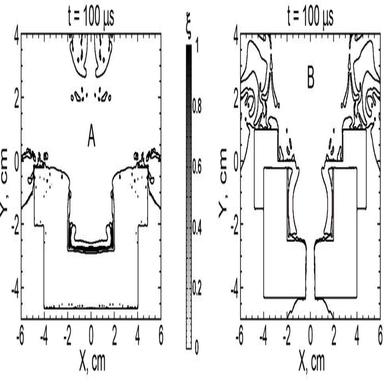
Results of the consolidation modelling (parameter ξ) for the diatomaceous earth, ρ0 = 0.14 g/cm3 .